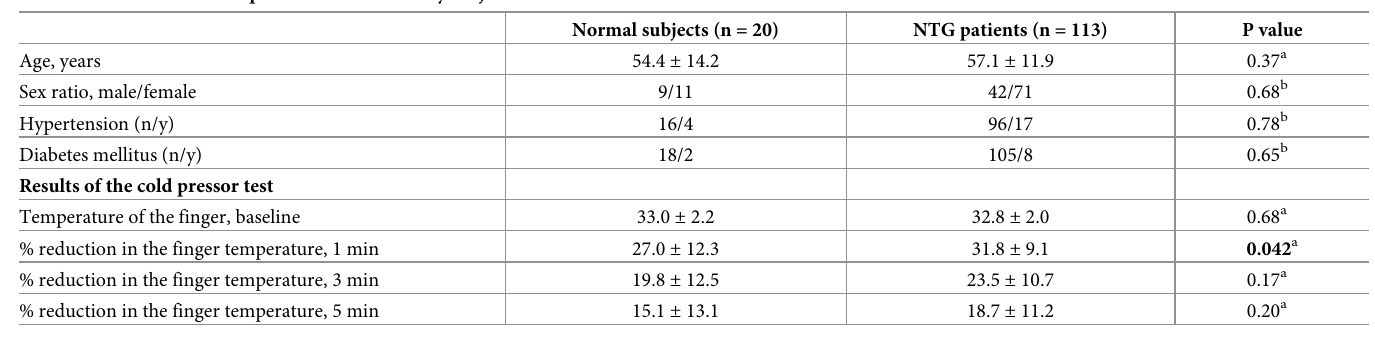
Table 2. Results of the cold pressor test in the study subjects.